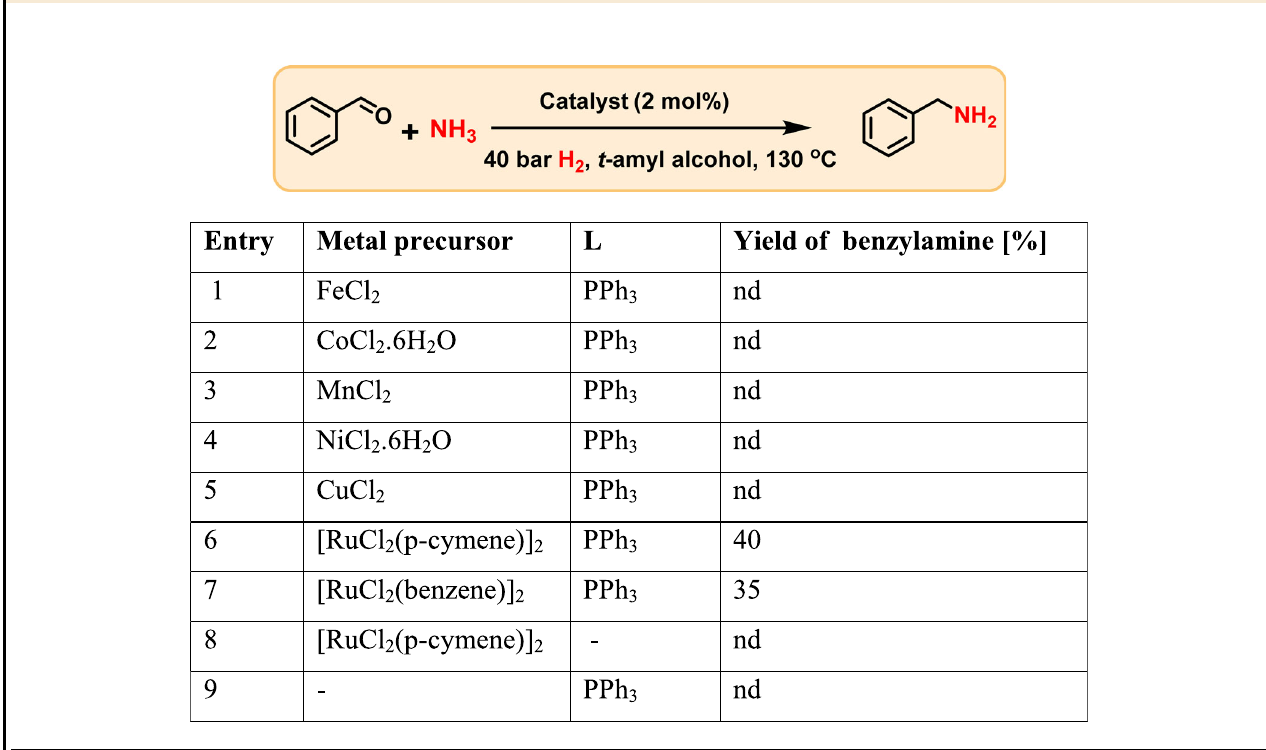
Table 1 Reductive amination of benzaldehyde: activity of different